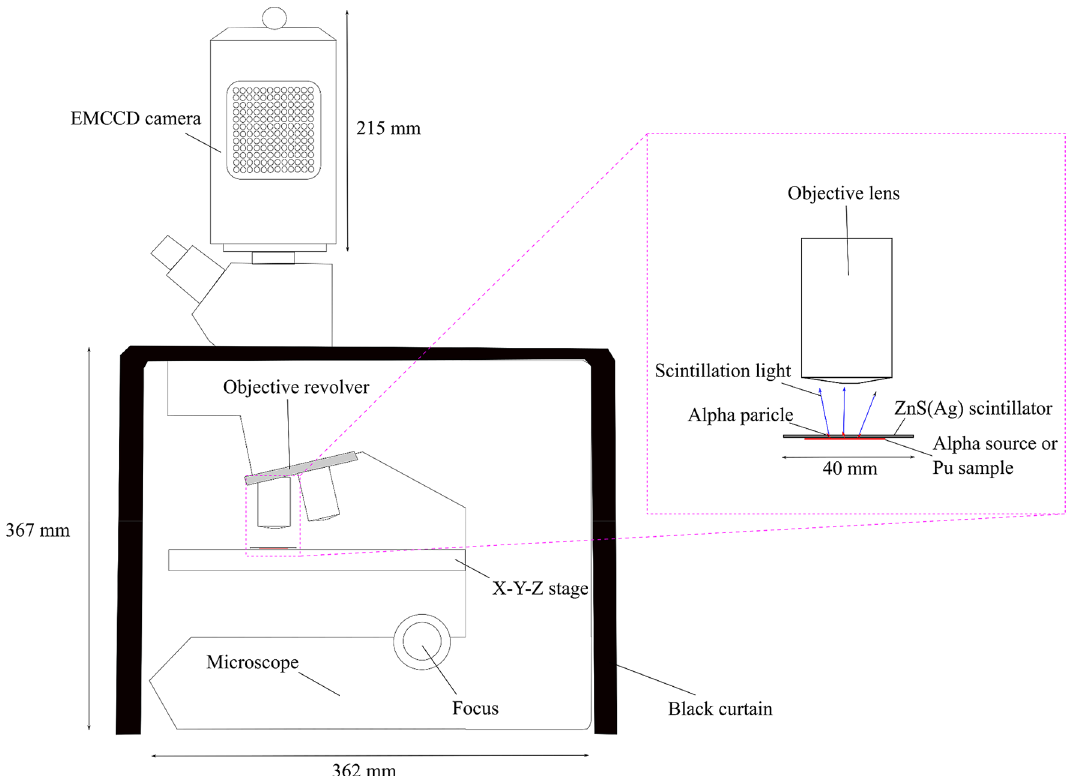
Figure 8. Schematic drawing of the developed high-resolution alpha imager.